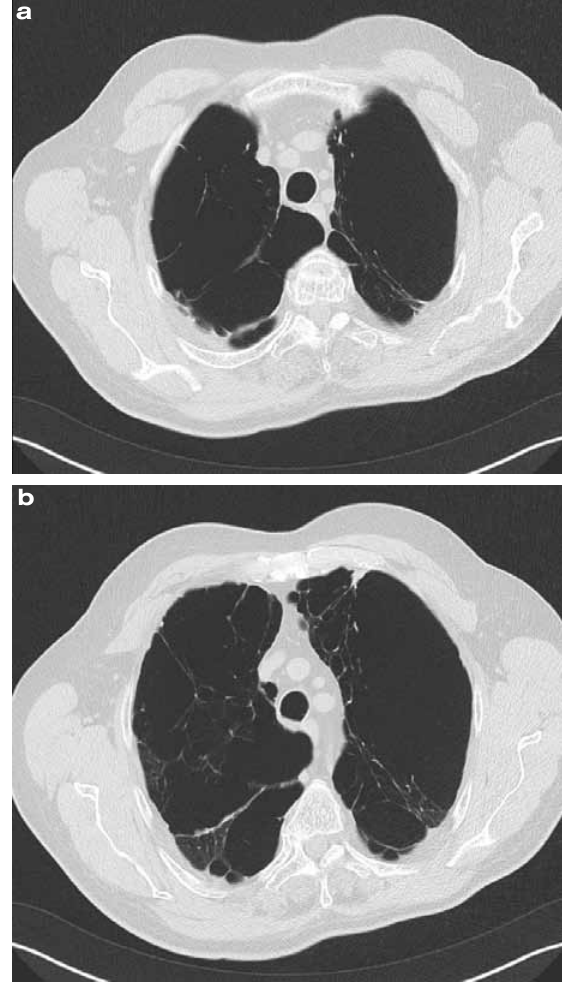
Figure 2. a CT- scan revealed severe heterogeneous centrilobular lung emphysema with bilateral involvement of the upper lobes. b CT- scan revealed severe heterogeneous centrilobular lung emphysema with bilateral involvement of the upper